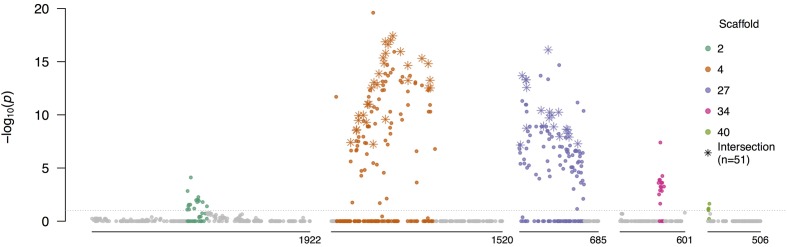
Allele frequency differences between isolates of opposite mating types. Negative log10-transformed P-values, adjusted for multiple testing, from the Fisher’s exact test of allele frequency differences between A1 and A2 isolates in the field F1, plotted against physical position, for scaffolds with significantly differentiated regions (see Supplementary Table S8 for coordinates). Colored SNPs were within the bounds of the minimum and maximum significant SNPs in each scaffold containing at least two significantly associated SNPs within 200 kb. Stars indicate the SNPs which were significant in tests of allele frequency differences between mating types in both the field F1 and inbred subpopulations (Supplementary Text). All SNPs above the gray horizontal line were significant after the FDR correction (α = 0.1).